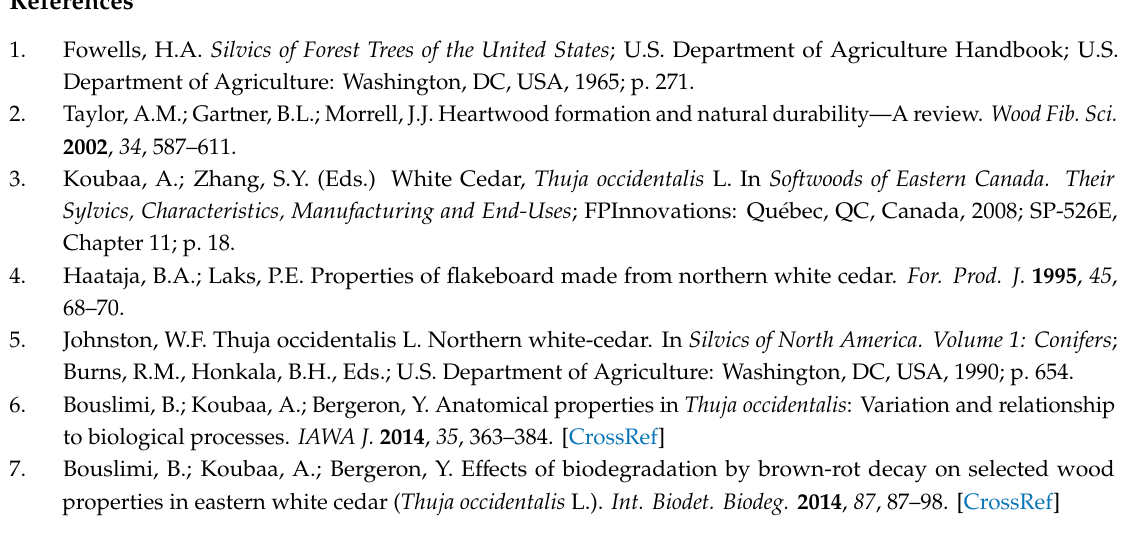
Figure A1. Example of intra- ring wood density profile modeled by Matlab software, using the maximum derivative method with a six-degree polynomial at selected growth rings.